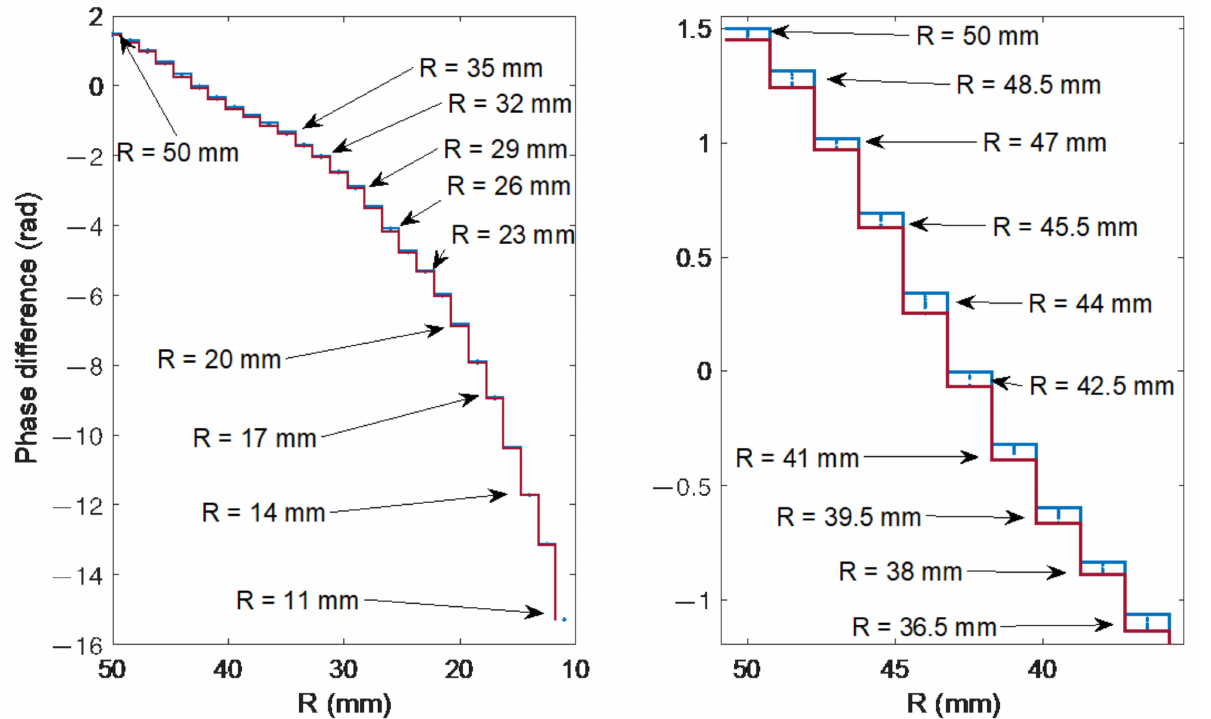
Figure 13. Phase changes (frequency of 2.3354 1/nm) of the spectra from Figure 10 for 27 bending radii.